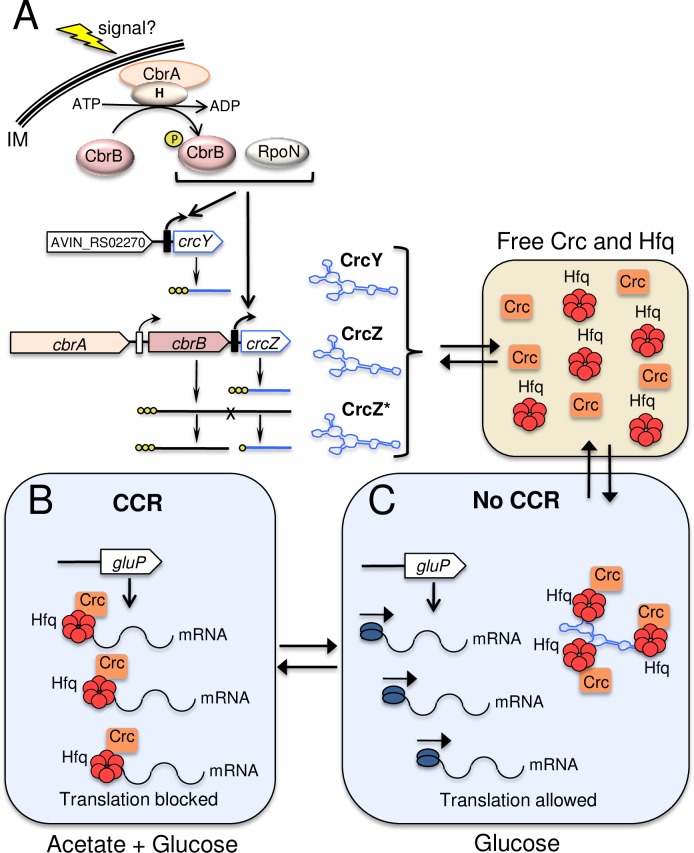
Model for the regulation of CCR in A. vinelandii, in diauxic glucose-acetate growth.A. The two-component system CbrA/CbrB is necessary for the expression of crcZ and crcY sRNAs genes from their RpoN-dependent promoters. A variant of CrcZ (CrcZ*) is produced from the processing of a cbrB-crcZ co-transcript, which is expressed from PcbrB. CrcZ, CrcZ* and CrcY sRNAs antagonize the translational repressing effect of Hfq-Crc on target genes. The phosphate groups at the 5’ end of crcY, crcZ and crcZ* transcripts are represented by yellow circles B. In the presence of both, acetate and glucose, translation of the gluP mRNA, encoding the glucose transporter, is inhibited by Hfq-Crc. C. This repression is alleviated as a consequence of the activation of the two-componente system CbrA/CbrB once the acetate is consumed, resulting in higher levels of CrcZ and CrcY, which sequester Hfq-Crc. For simplicity, other Hfq-Crc targets during glucose CCR are not shown [5]. Only three out of the six A-rich Hfq binding motifs of CrcZ/Y are represented to bind Hfq-Crc.